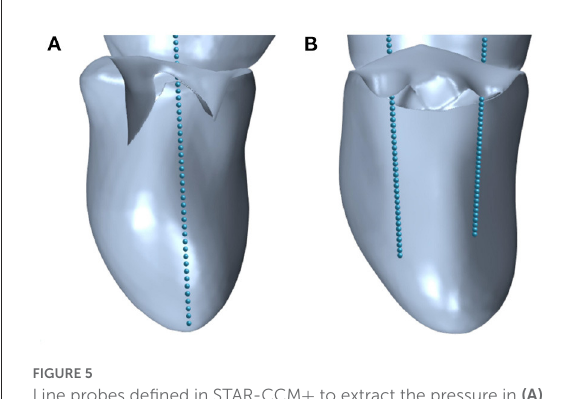
FIGURE5 Line probes defined in STAR-CCM + to extract the pressure in (A) pre-interventional geometries with single orifice and (B) post-interventional geometries with double